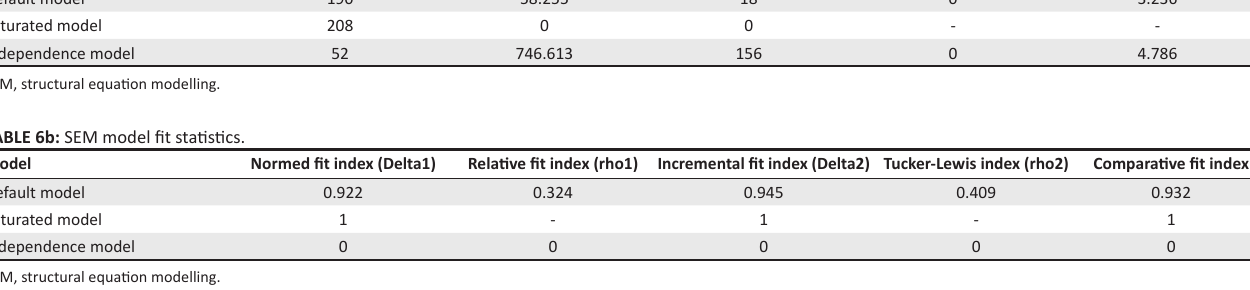
TABLE 6a: SEM model fit statistics. Model